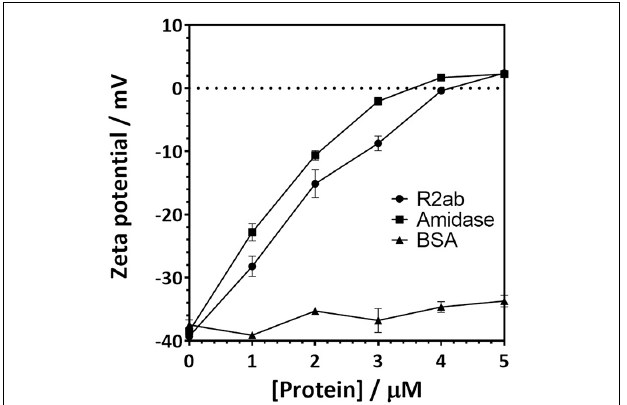
FIGURE 3 | Zeta potential changes when carboxylate functionalized PSNPs are titrated with autolysin domains. The zeta potential of 20 nm